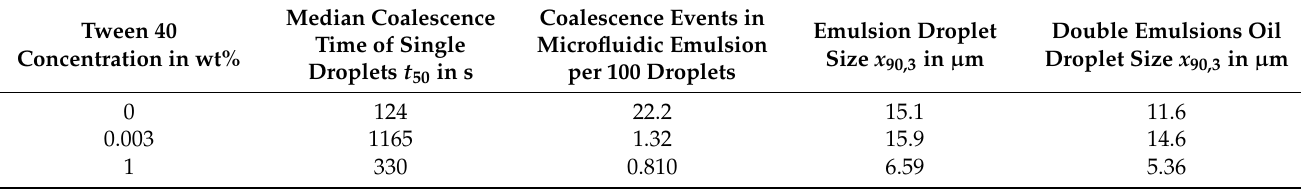
Table A3. Comparison of the effect of the three different measurement methods on the example of different Tween 40 concentrations with the addition of Span 80. For the microfluidic experiment, the values are from after one day. The values for the emulsification experiments directly after production are also